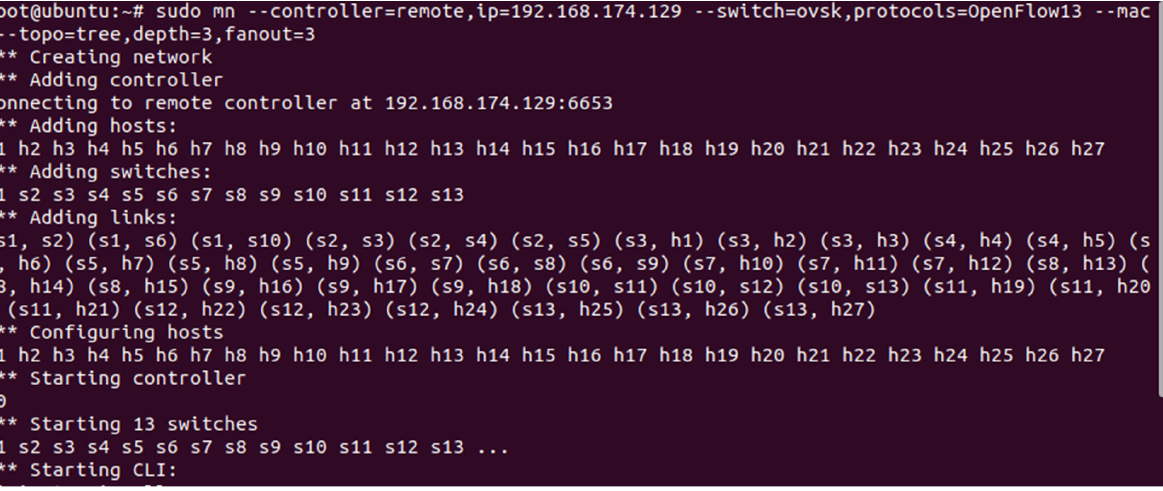
Figure 21. Create custom tree network topology with ODL controller.